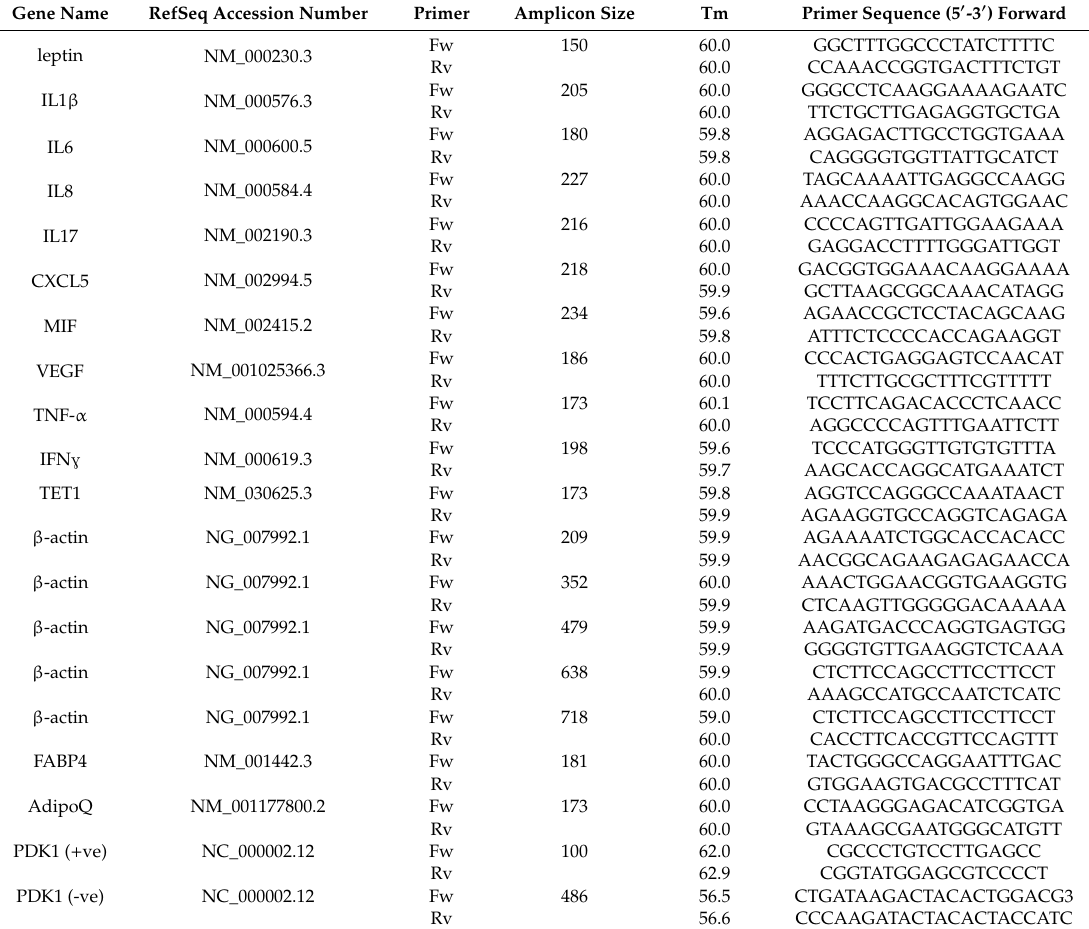
Table 1. Sequences of primers used for real-time